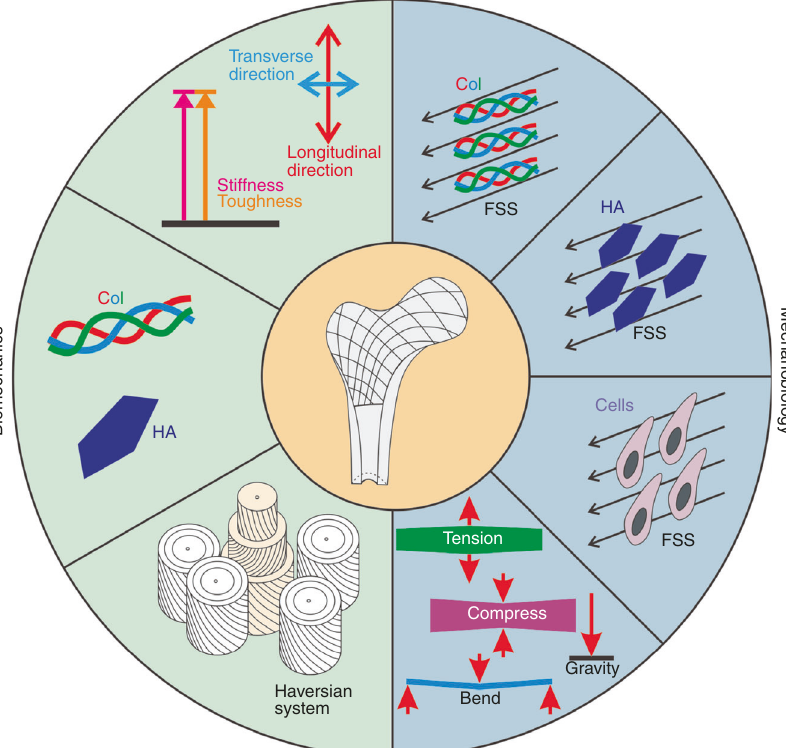
Fig. 1 Schematic representation of the biomechanical properties of the bone matrix and the effects of mechanical stimuli on the bone matrix components, Col and HA, and bone-related cells, such as mesenchymal stem cells, osteocytes, osteoblasts,